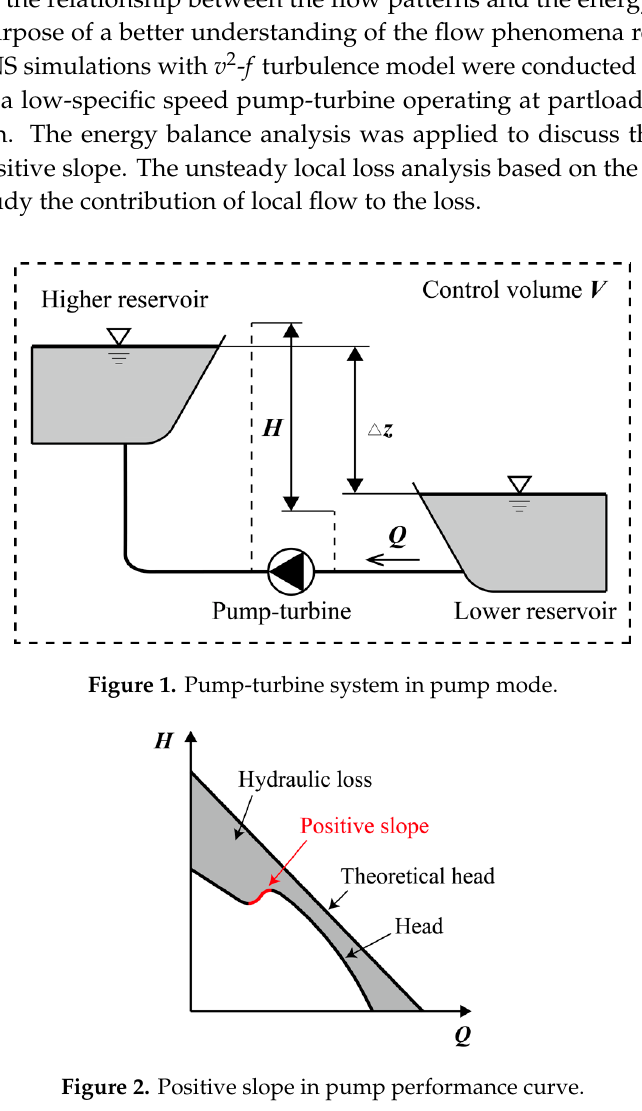
Table 1. Geometric parameters of the model pump-turbine.